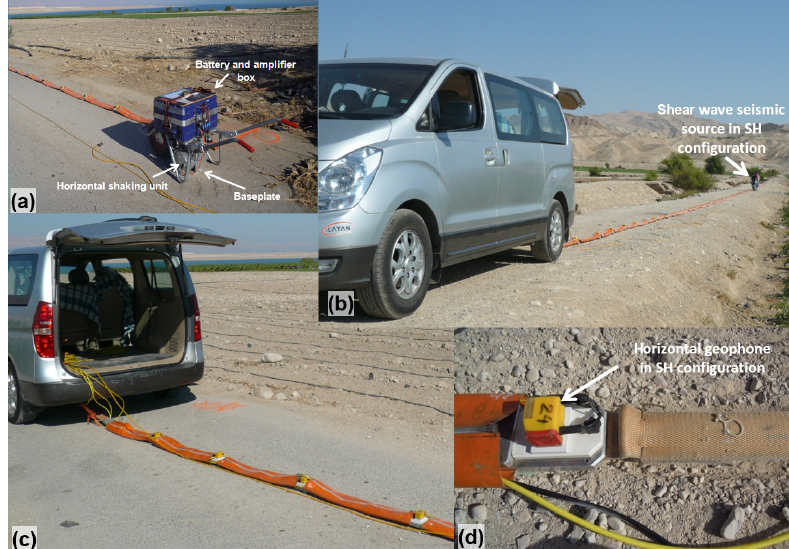
Figure 3. Photos of the shear wave seismic reflection acquisition campaign carried out in October 2013. (a) Wheelbarrow-mounted shear wave source system on asphalt pavement at start location of profile 2. (b) Recording car, towed land streamer and source during operation on profile 3. (c) Land streamer towed by the recording car during acquisition on profile 2. Colour paintings on the road surface were used for location numbering along the profiles. (d) Sledge-mounted horizontal geophone in SH (particle movement perpendicular to profiling direction) configuration along profile